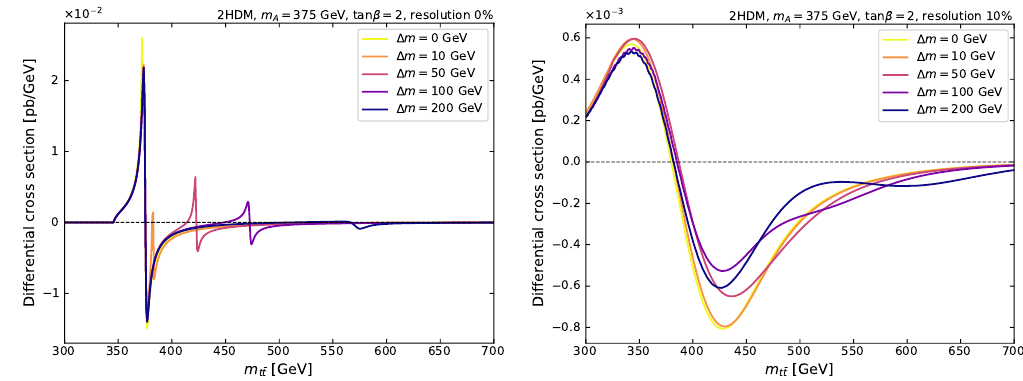
Figure 16 . The di(cid:11)erential cross section with perfect resolution (left) or 10% smearing (right) for several mass splitting M H (cid:0) M A = 0 ; 10 ; 50 ; 100 ; 200 GeV. the [ M ; M ] plane. Also shown is a dashed line where M H V LQ H ! Q (cid:22) Q decays are kinematically allowed. The region where the decays to VLQ are allowed is problematic since the total width becomes then larger than (cid:0)((cid:8) ! t (cid:22) t ) that we pair production is likely to provide more distinctive signatures for larger M